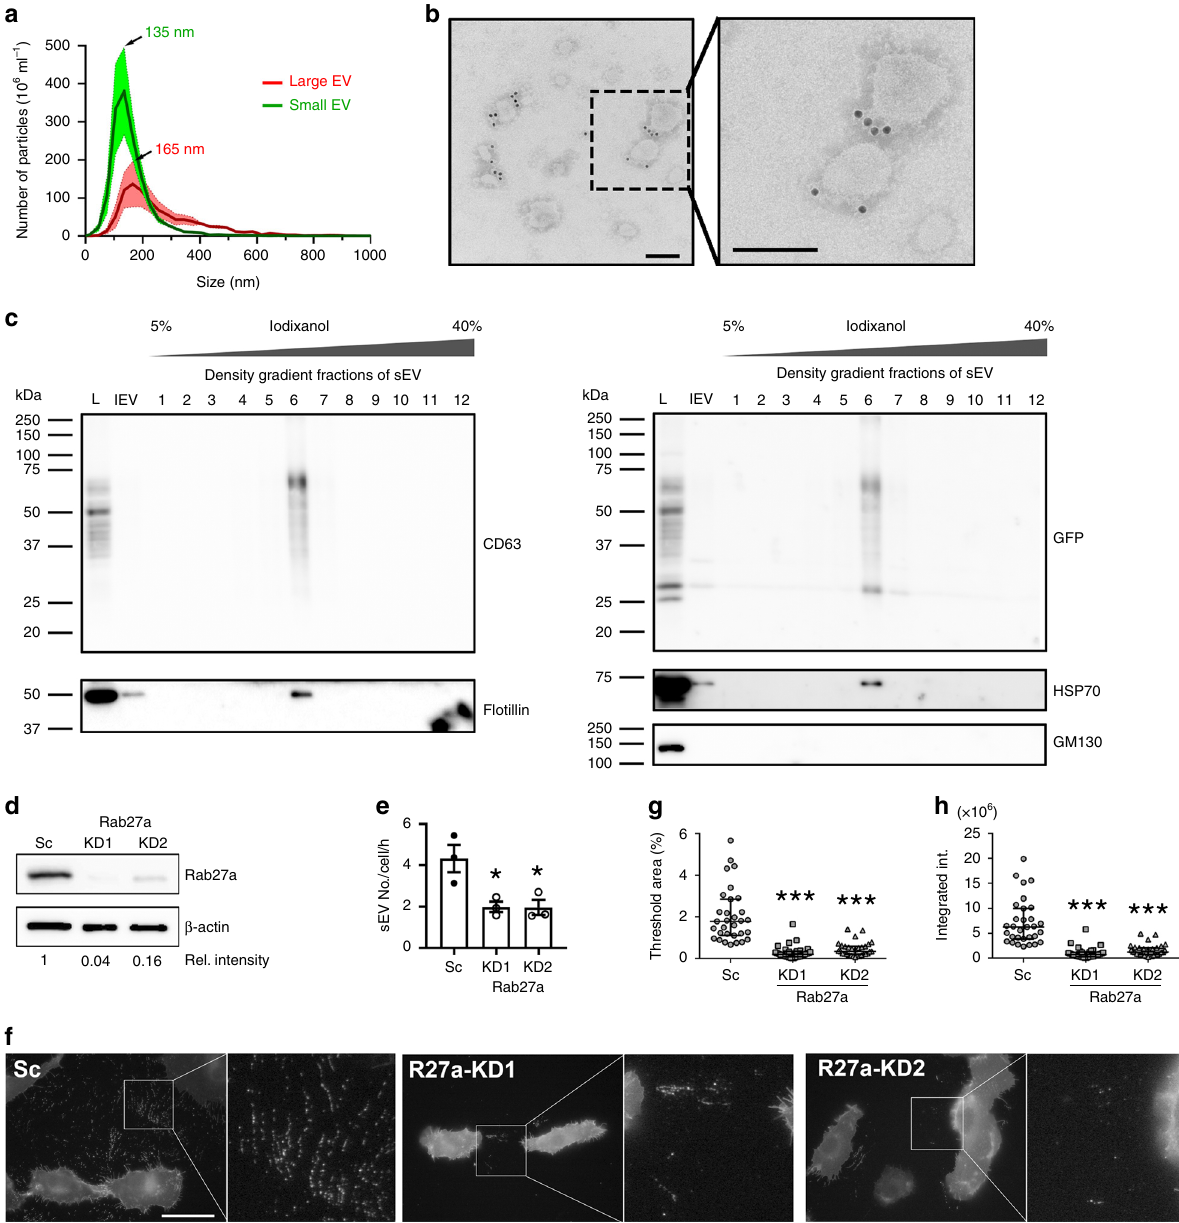
Fig. 2 pHluo_M153R-CD63 labels exosomes. a Averaged trace from nanoparticle tracking analyses of large EVs (red) and small EVs (green) secreted from pHluo_M153R-CD63-expressing HT1080. Shaded area represents s.e.m. from three independent experiments. Small EVs were puri fi ed through iodixanol density gradient. b Representative immunogold negative stain electron micrograph of small EVs iodixanol density-gradient-puri fi ed from pHluo_M153R- CD63-expressing HT1080 from two independent experiments. Scale bars, 100 nm. c Western blot analysis of cells and EVs with anti-CD63, anti-GFP, EV markers (Flotillin, HSP70) and Golgi marker (GM130). L total cell lysate, lEV large EV, sEV small EV. d Immunoblotting of Rab27a in pHluo_M153R-CD63- stably expressing HT1080. Sc scrambled control, KD knockdown. e Comparison of small EV (sEV) secretion rate between control and Rab27a-KDs shown as a scatter-plot (mean± standard error) from three independent experiments. * P = 0.030793 and 0.031077 for Rab27a-KD1 and KD2, respectively, by two-sided paired Student ’ s t test. f − h Live imaging and analysis of extracellular pHluo_M153R-CD63 for control and Rab27a-KD cells. f Representative images, n = 31 images from three independent experiments for each cell line. R27a, Rab27a. Scale bar, 30 µ m. g Threshold area of the extracellular region from ( f ) shown as a scatter-plot (median and quartile range). *** P < 0.001 by two-sided unpaired Mann − Whitney U test. h Integrated intensity of the extracellular region from ( f ) shown as a scatter-plot (median and quartile range). *** P < 0.001 by two-sided unpaired Mann − Whitney U test. Source data are provided as a Source Data fi